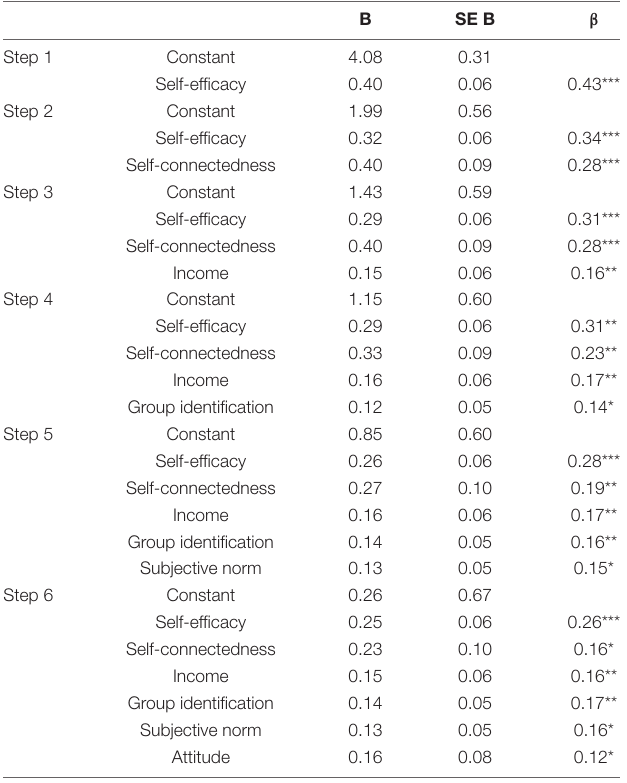
TABLE 3 | Multiple regression—behavioral intention to recycle in the coming month.